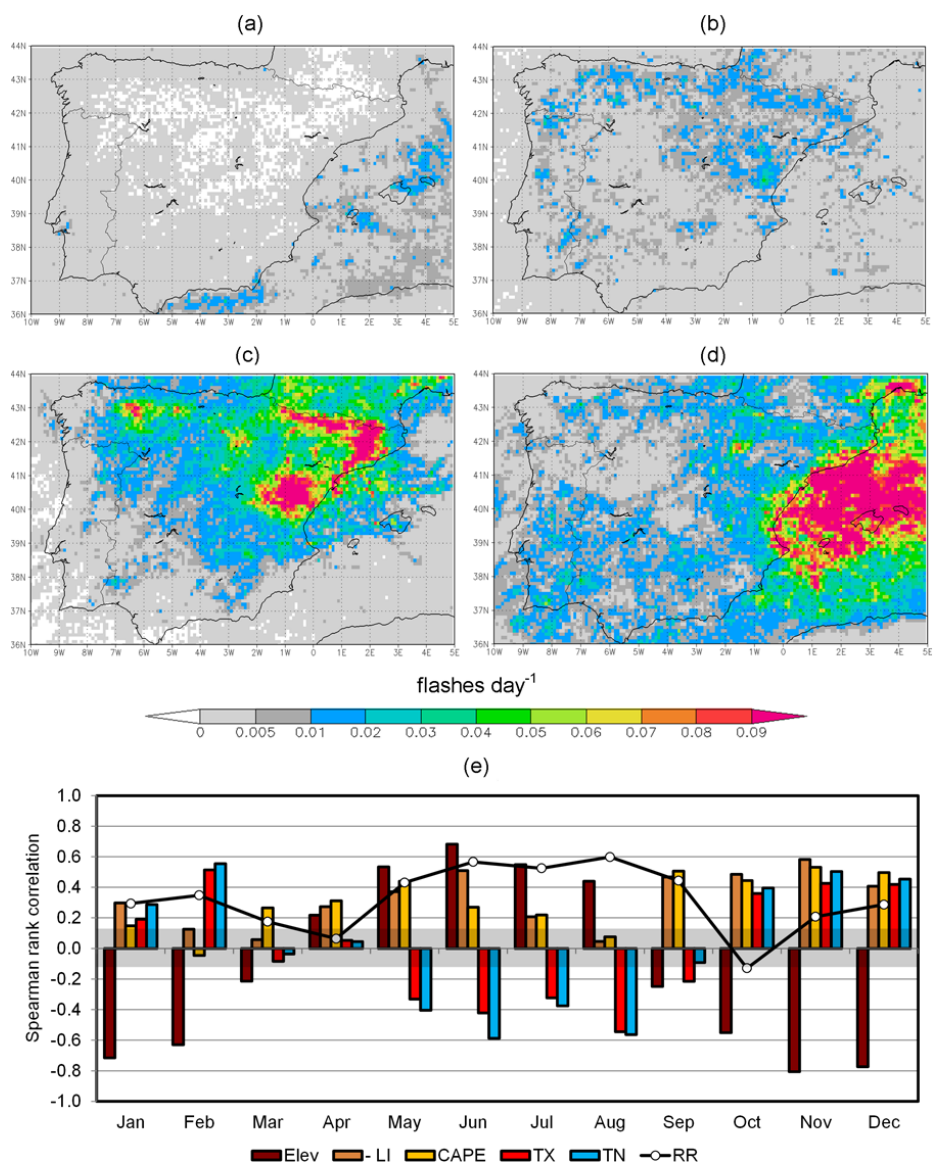
Fig. 4. Maps of the 7yr (2003–2009) (a) DJF, (b) MAM, (c) JJA, and (d) SON means of the daily CGFs (flashesday − 1 ) recorded within the Iberian sector (36–44 ◦ N, 10 ◦ W–5 ◦ E). (e) Spatial Spearman rank correlations between the 7yr monthly means of CGF occurrences and the selected five forcing factors: elevation (Elev), monthly means of the opposite of the lifted index ( − LI), convective available potential energy (CAPE), and daily minimum (TN) and maximum (TX) 2m air temperatures. The correlations with the monthly precipitation totals (RR) are also displayed (black line). Grey shading indicates the 95% confidence interval of non-statistically significant correlations.